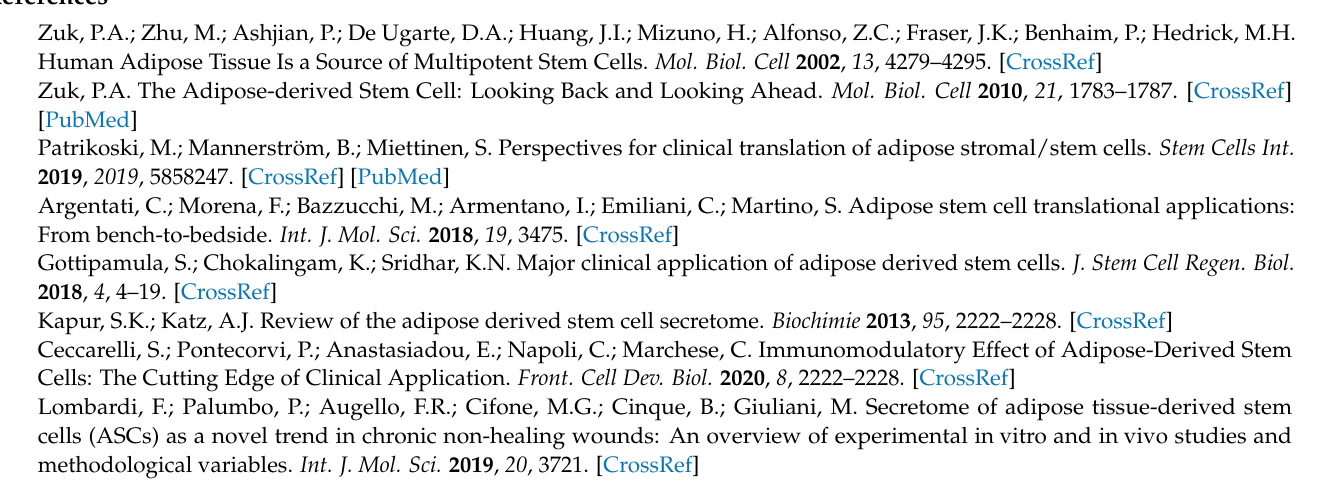
array, Table S8: Human chemokine array, Table S9: Detailed information of the antibodies used for the flow cytometric measurements, Table S10: Reverse transcription detailed procedure, Table S11: RT-qPCR cycle conditions, Table S12: Primer sequences, Table S13: Materials. References [143–172] are cited in the Supplementary